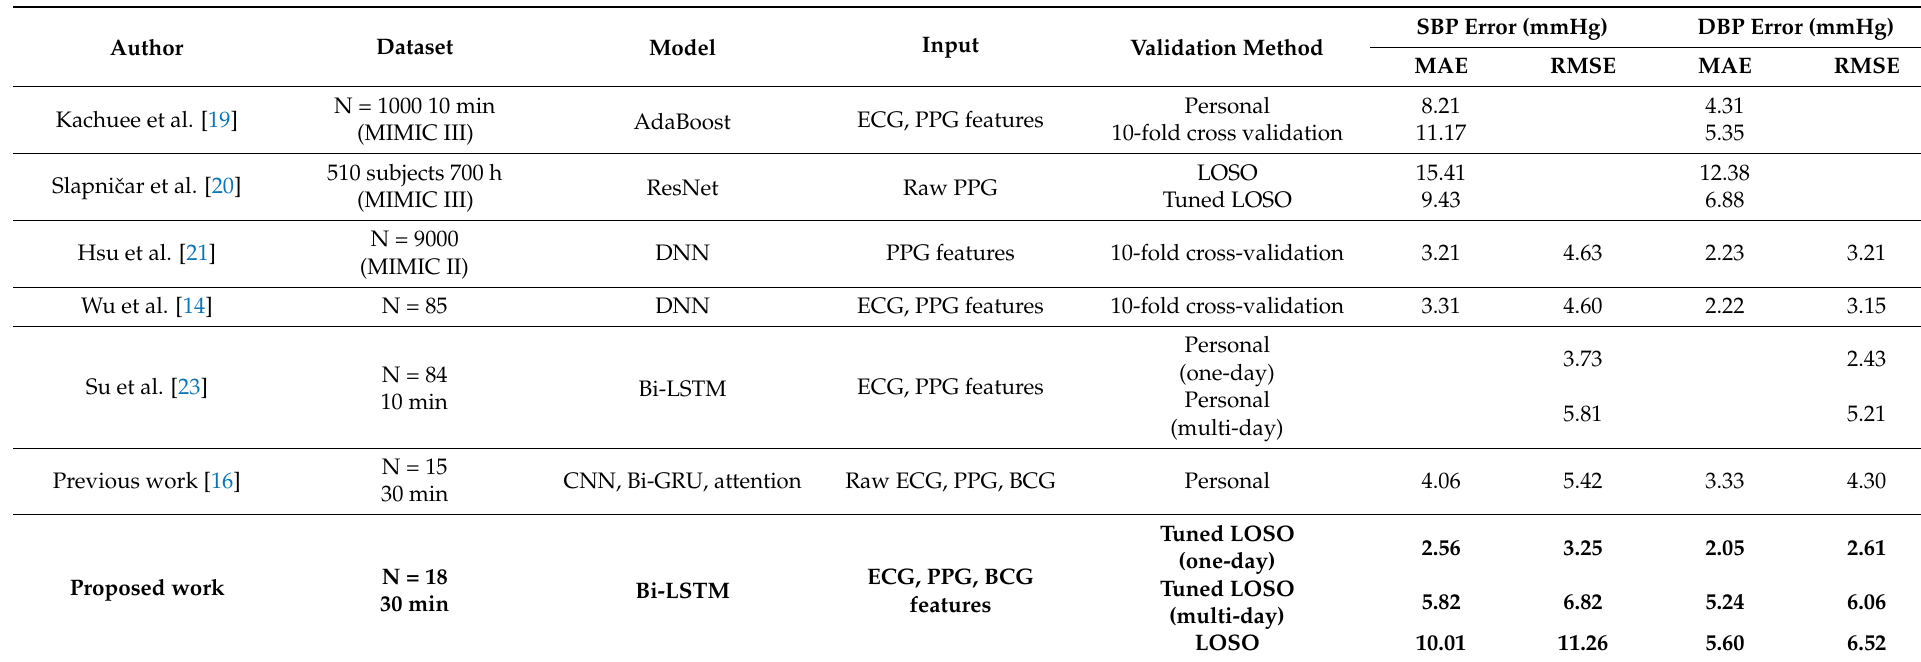
Table 9. Comparisons with related